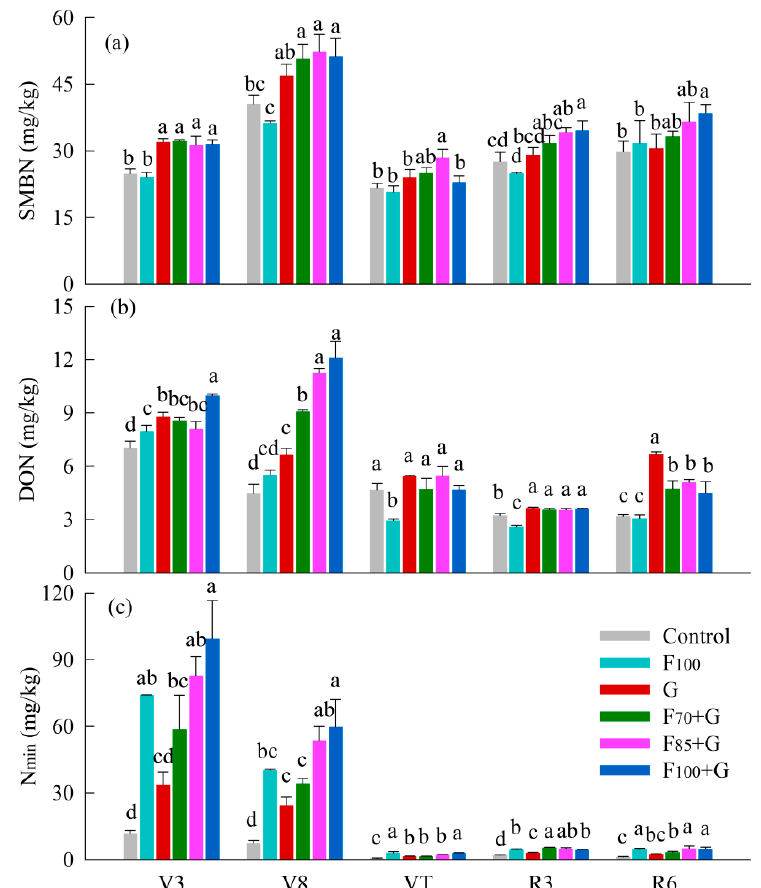
Figure 5. Changes in ( a ) soil microbial biomass N (SMBN), ( b ) dissolved organic N (DON), and ( c ) mineral N (N min ) in the 0–20 cm soil layer during maize growth. Data are mean ± standard error (vertical bars, n = 4). Different letters above columns at each harvest indicate statistical differences between treatments by LSD test ( p < 0.05). V3 and V8 (the third and eighth leaf fully expanded, respectively), VT (tasseling), R3 (milk), and R6 (physiological maturity). Control, no fertilization; F 100 , recommended inorganic fertilization alone; G, green manure incorporation alone; F 70 + G, F 85 + G, and F 100 + G are 70%, 85%, and 100% of F 100 plus G, respectively.